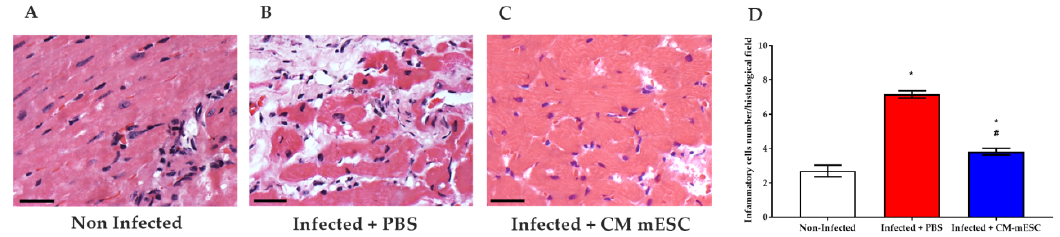
Figure 8. Analysis of inflammatory cells. ( A – C ) Representative images of histological cardiac sections stained with hematoxilin-eosin: ( A ) Non-infected group, ( B ) Infected + PBS group, and ( C ) Infected + CM-mESC group 45 days after cell transplantation. ( D ) The graph shows that the Infected + PBS group exhibited a higher number of inflammatory cells when compared to the Non-infected group. CM-mESC therapy attenuated significantly the number of inflammatory cells compared to the PBS treated group. One away ANOVA with Tukey’s comparison test: * p < 0.05 compared to the Non-infected group; # p < 0.05 compared to the Infected + PBS group. Data are shown as mean ± standard error of the mean; n = 5 for each group. CM-mESC—cardiomyocytes derived from mouse embryonic stem cells. Scale bar: 50 µm.